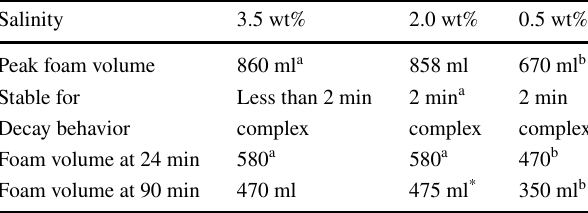
Table 7 Summary of the modified bulk foam stability test results for the effect of salinity